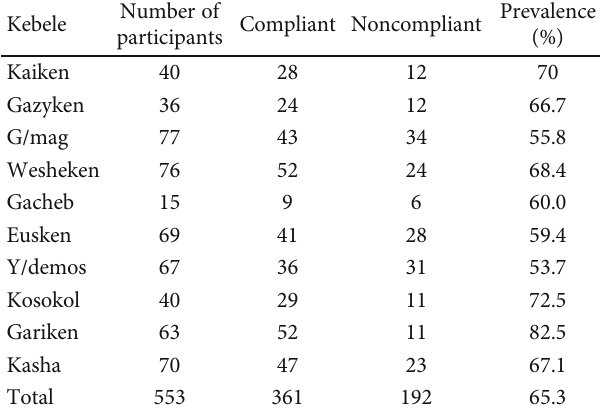
Table 2: Prevalence of compliance to ivermectin treatment among the studied kebeles in the Semen Bench District, Bench Maji Zone, Southwest Ethiopia, June 2018 ð n = 553 Þ